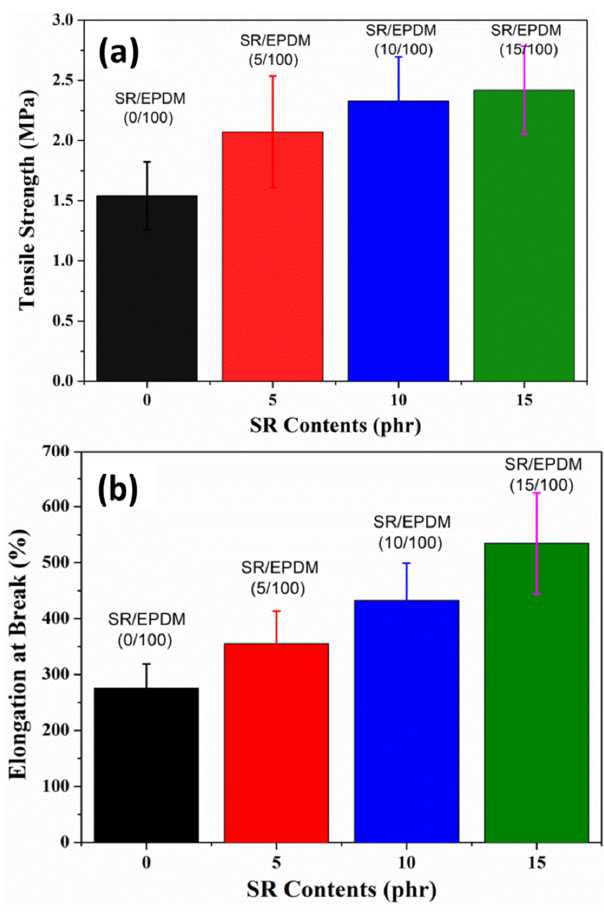
Figure 6. ( a ) Tensile strength; and ( b ) Elongation at break of SR/EPDM composites with different SR